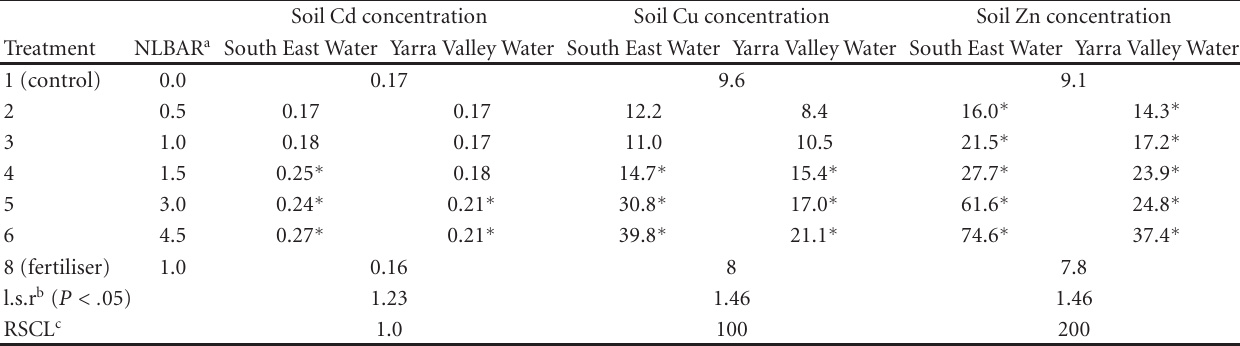
Table 4: Soil Cd, Cu, and Zn concentrations (mg/kg) at Pakenham immediately after the application of biosolids in 2004. Soil Cd concentration Soil Cu concentration Soil Zn concentration Treatment